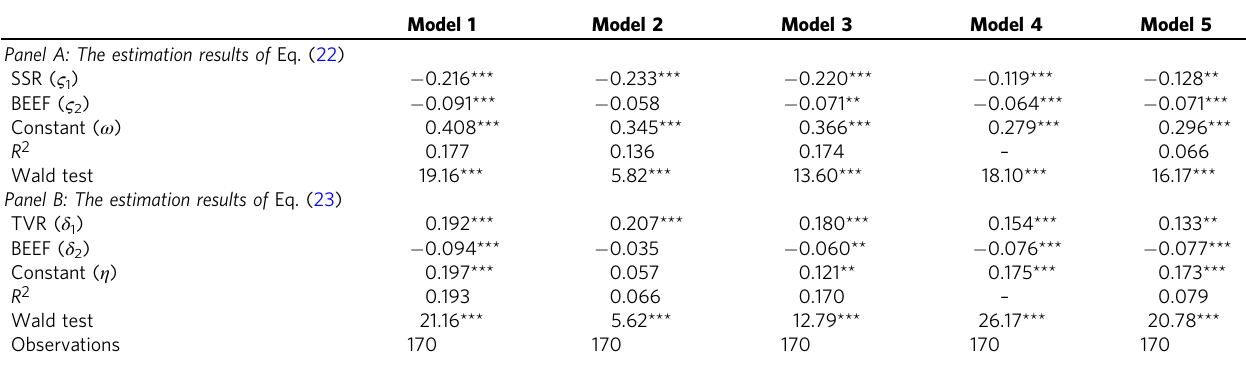
Table 11 Estimation results of panel data analysis.